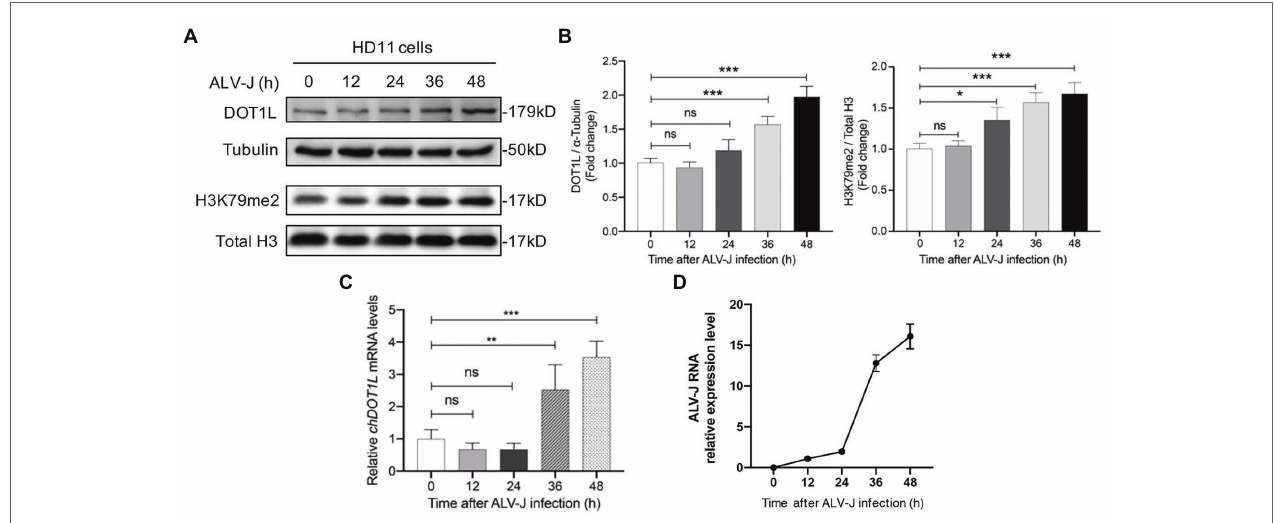
FIGURE 1 | Disruptor of telomeric silencing 1-like (DOT1L) expression and H3K79me2 levels are upregulated during avian leukosis virus subgroup J (ALV-J) infection in chicken macrophage cell line HD11. (A,B) Western blot (A) and intensity (B) for DOT1L protein and DOT1L-mediated H3K79me2 levels in HD11 cells at the indicated time points post infection with ALV-J (MOI 2). α -tubulin and total H3 were used as a loading control. (C) The relative DOT1L mRNA levels in HD11 cells at the indicated time points post infection with ALV-J, measured by quantitative real-time reverse transcription PCR (qRT-PCR). GAPDH was used as a normalizing control. (D) The relative ALV-J RNA level in HD11 cells at the indicated time points post infection, normalized to chicken GAPDH mRNA, was measured by qRT-PCR. All the data were shown as mean ± SD (error bars) from three independent experiments. ns, not significant; * p < 0.05; ** p < 0.01; *** p < 0.001; unpaired, two-tailed Student’s t